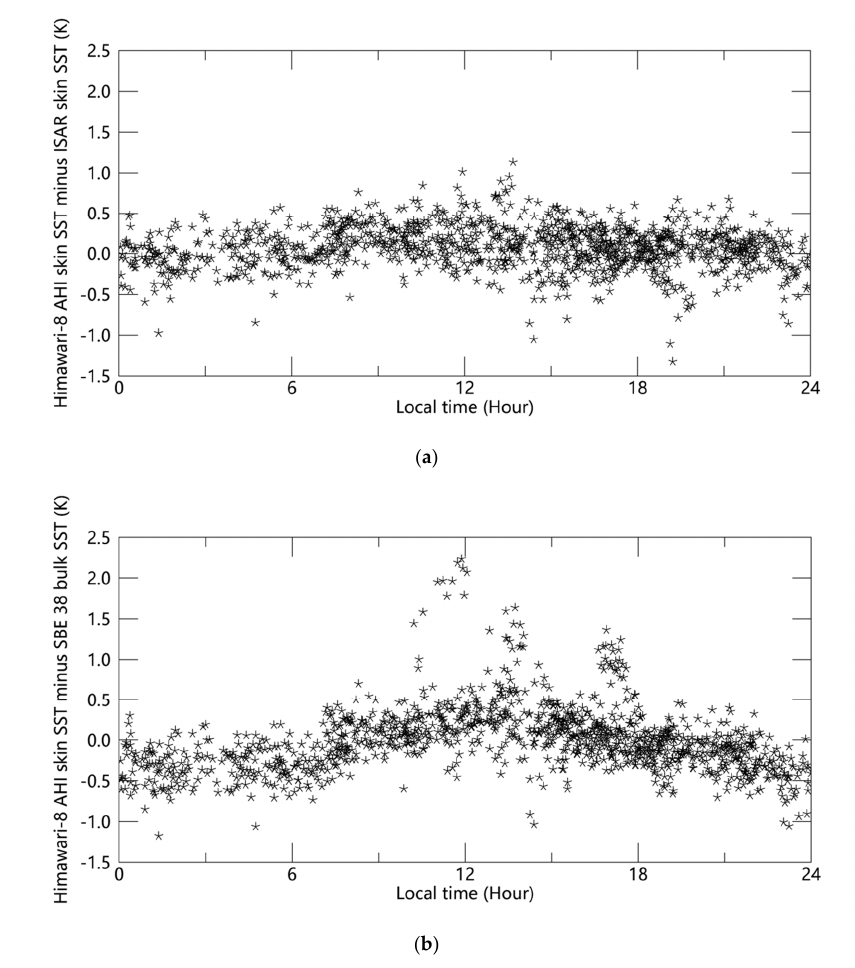
Figure 4. ( a ) Himawari-8 AHI and ISAR skin SST matchups against local time; ( b ) Himawari-8 AHI skin SST and SBE 38 bulk SST matchups against local time. Table 5. Statistics of SST difference of the matchups for cruise IN2016_V05.